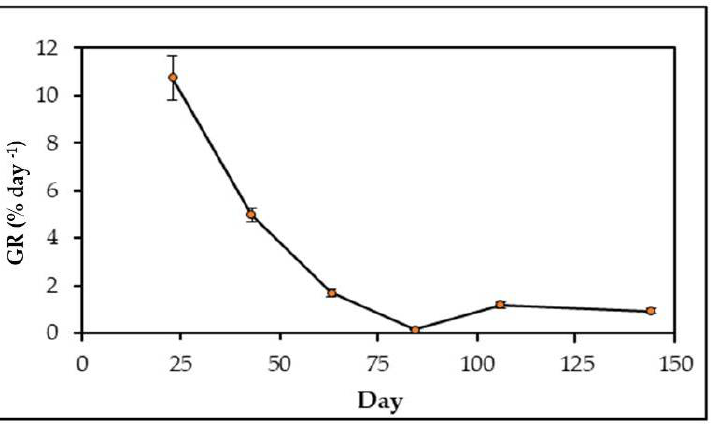
Figure 4. Growth rates of Gracilaria gracilis during the period of cultivation in the aquarium. Error bars denote SE.